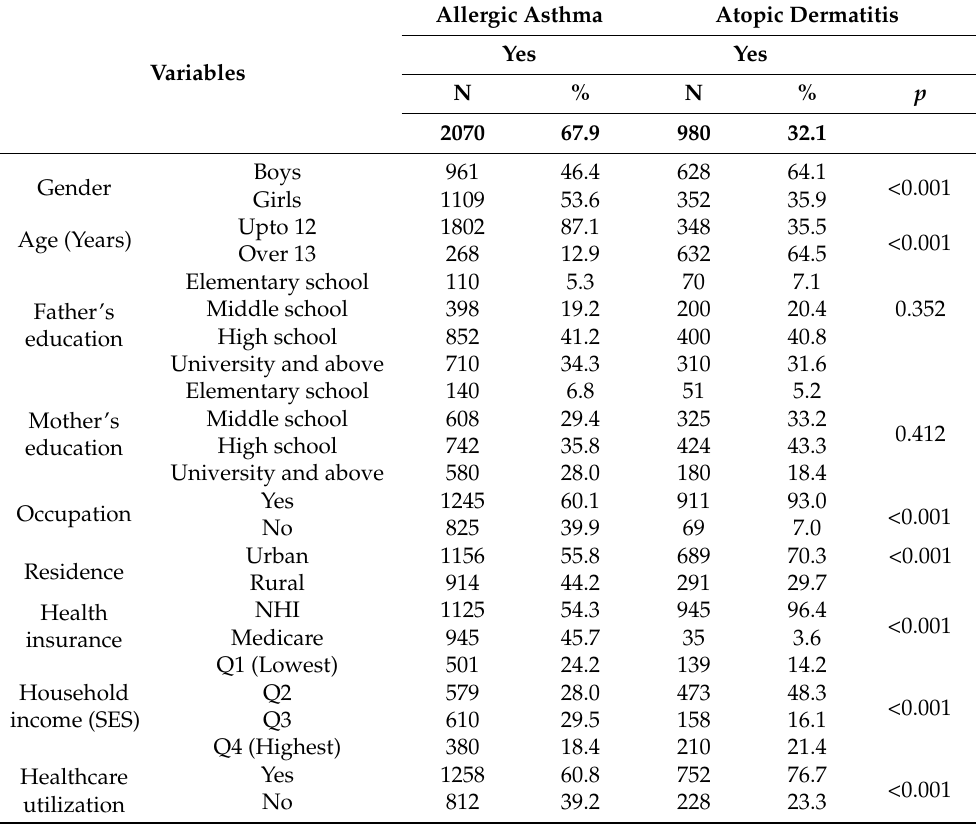
Table 1. General characteristics and distribution among children with allergic diseases (n = 3050).